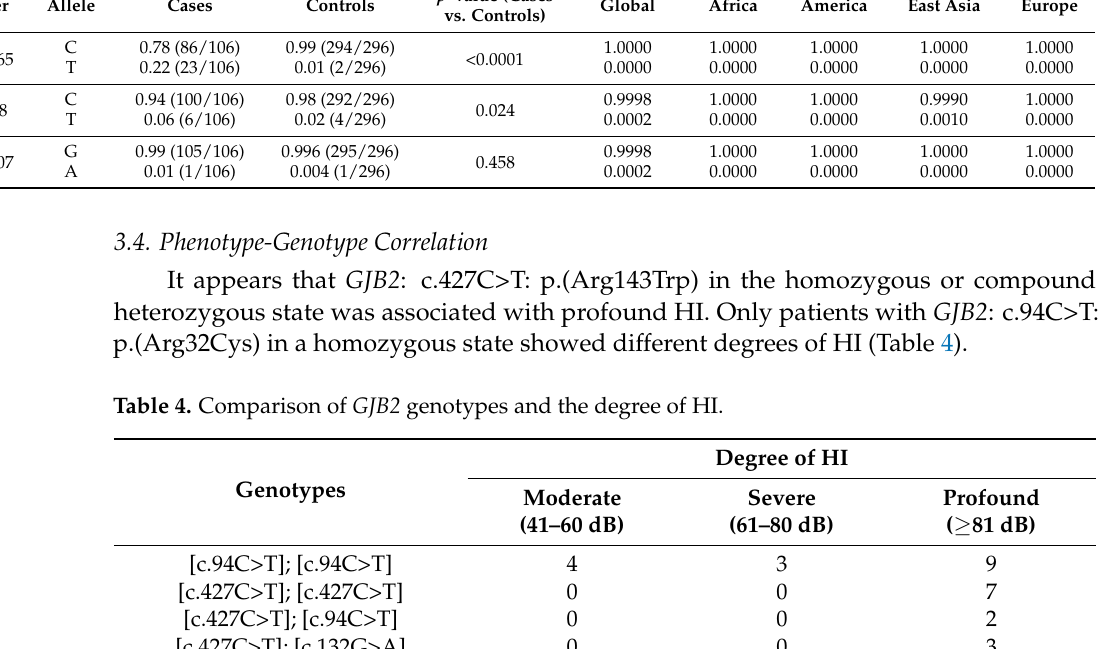
Table 3. Comparison of GJB2 variants identified in Senegal and other populations from Ensembl database. Allele Frequency ( n/N )